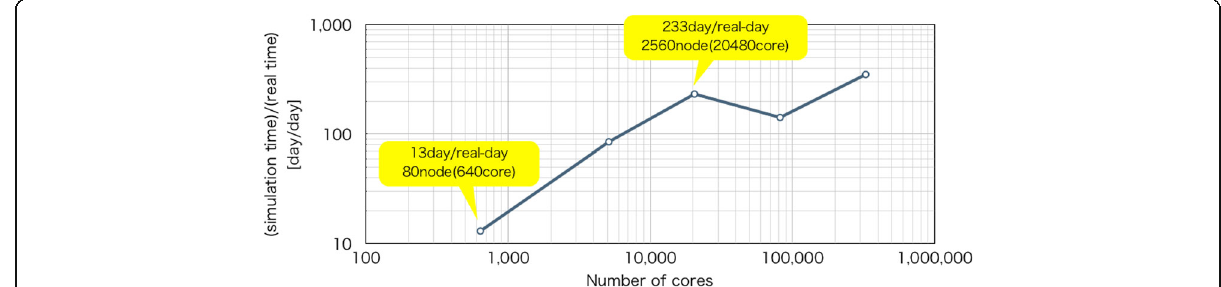
Fig. 2 Results of the strong scaling test on the K computer for the NICAM simulations. Vertical axis is simulation time per real time [day day − 1 ]. Horizontal axis is the number of